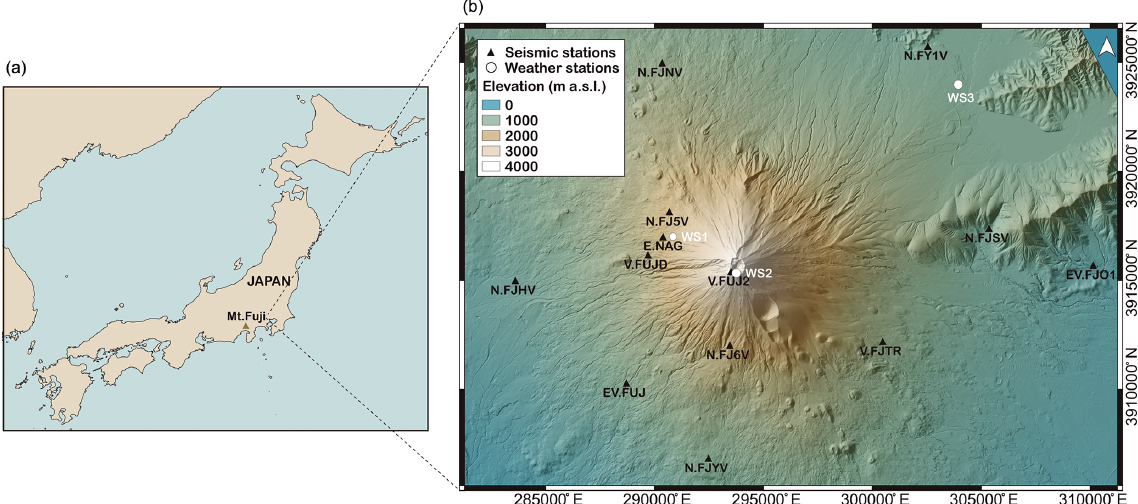
Figure 1. Overview map of Japan with the location of Mt. Fuji (a) and topographic map of the Mt. Fuji region (b) with the location of the 13 seismic stations and the 3 weather stations (WS1–WS3) used for this study. Seismic stations are labeled according to the institutions that operate them: N.F ∗ (NIED), EV. ∗ (ERI), V. ∗ (JMA), and E.NAG (NU and MFRI). Coordinates are given in UTM Zone 54N (JGD2000 datum)